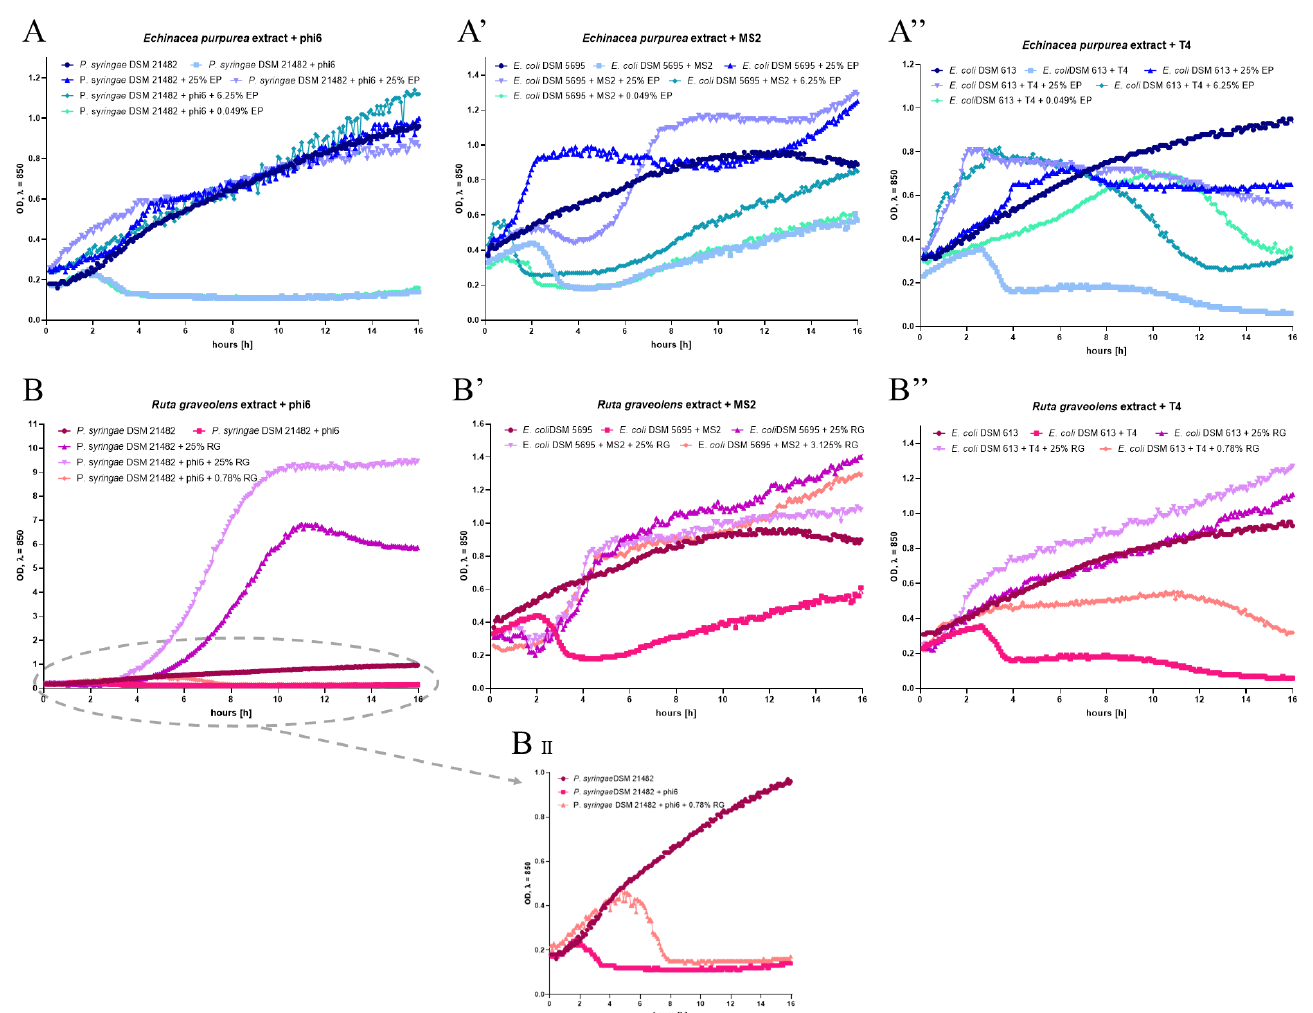
Figure 5. Bacteriophage lytic kinetics with different extract concentrations, chosen in the synogram experiment. Combined treatment of phages with the Echinacea purpurea extract (phi6 ( A ); MS2 ( A’ ); T4 ( A” )), combined treatment of phages with the Ruta graveolens extract (phi6 ( B ); MS2 ( B’ ); T4 ( B” ); phi6 exported results of the chosen curves from the B graph ( B ( II ))).